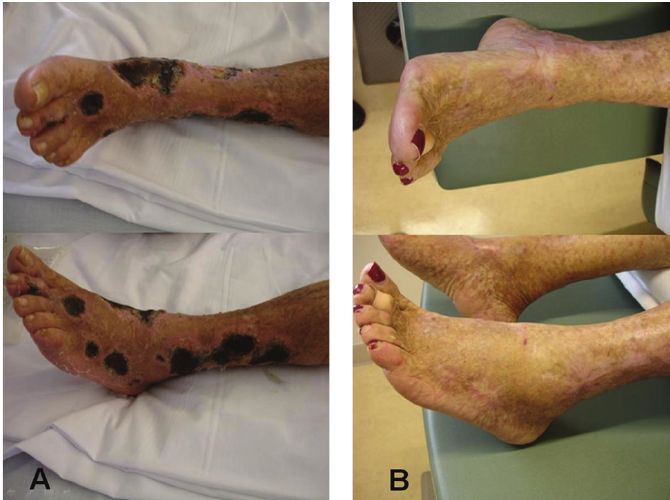
Figure 1: Leg ulcers associated to HCV infection in the case 2. (a) Pre- and (b) post-treatment with rituximab.